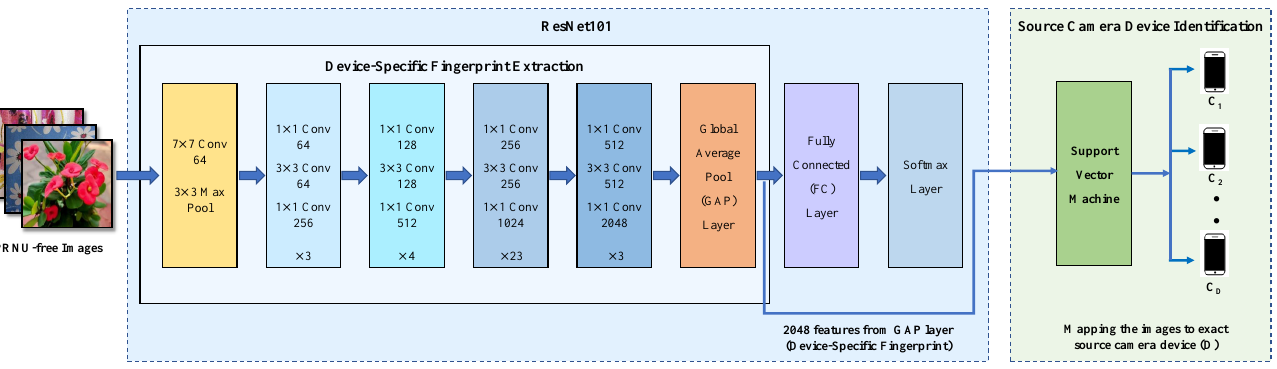
Figure 2. The hybrid ResNet–SVM to extract the new device-specific fingerprint without using PRNU to identify the source